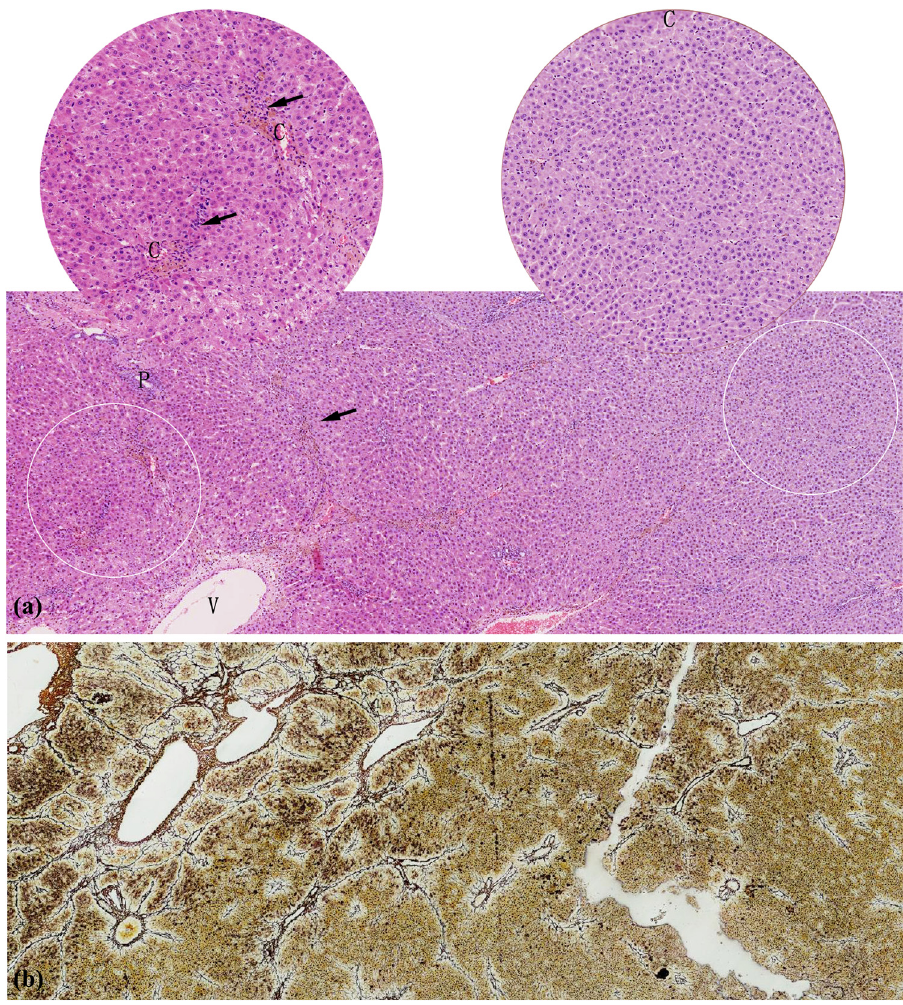
Figure 5: Pathological changes in the liver after administration for 8 weeks in DMF group. ( a ) Uneven lesions with cell degeneration and narrowed hepatic sinuses in some areas, necrosis, and in fl ammation ( arrow ) in other areas ( HE 40 × and HE 100 ×) . ( b ) Heterogeneous fi brosis was present in the same pathological section ( Reticulum Masson 20 ×) . C: central veins, V: hepatic vein, P: portal